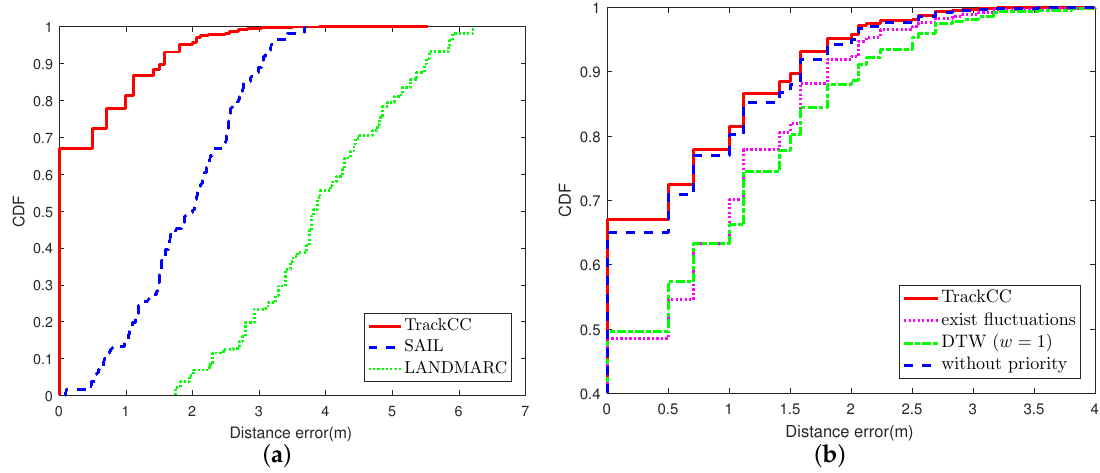
Figure 7. The performance evaluation of TrackCC in the case of non-line-of-sight (NLOS). ( a ) the performance in the case of NLOS ; ( b ) the detailed evaluation of NLOS